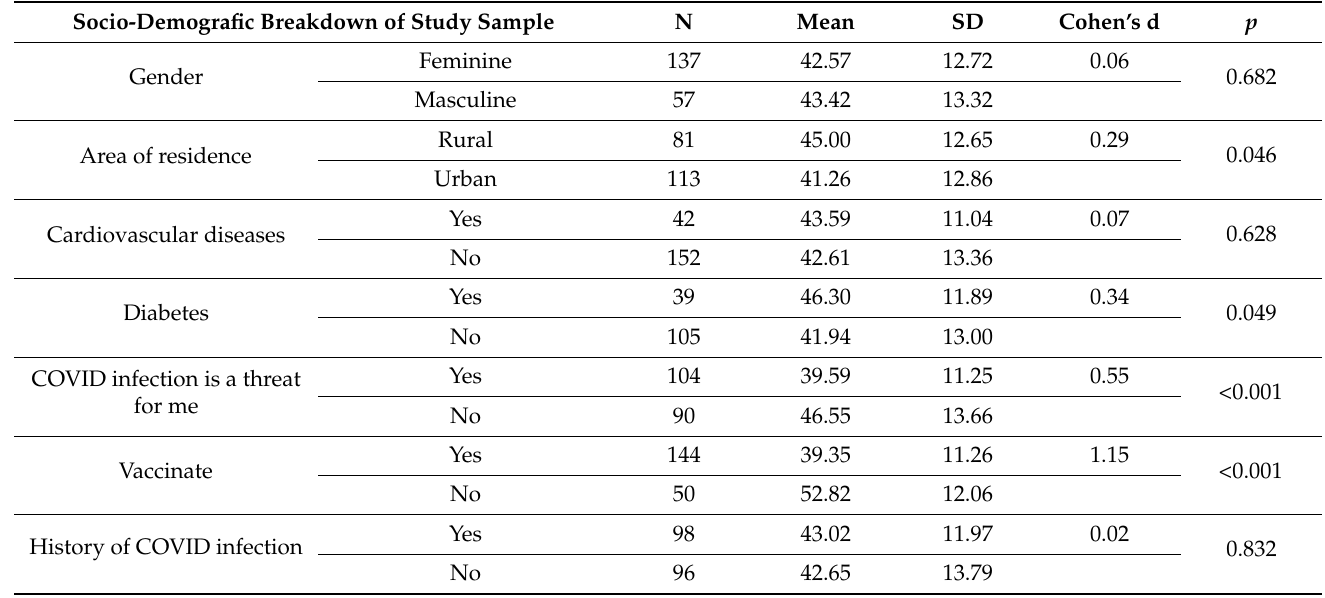
Table 3. Differences in score between